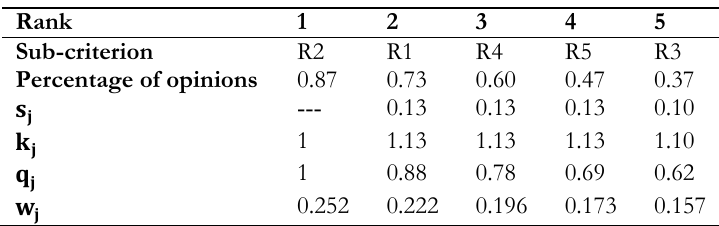
Table 17. Values of 𝐬 𝐣 , 𝐤 𝐣 , 𝐪 𝐣 and 𝐰 𝐣 .